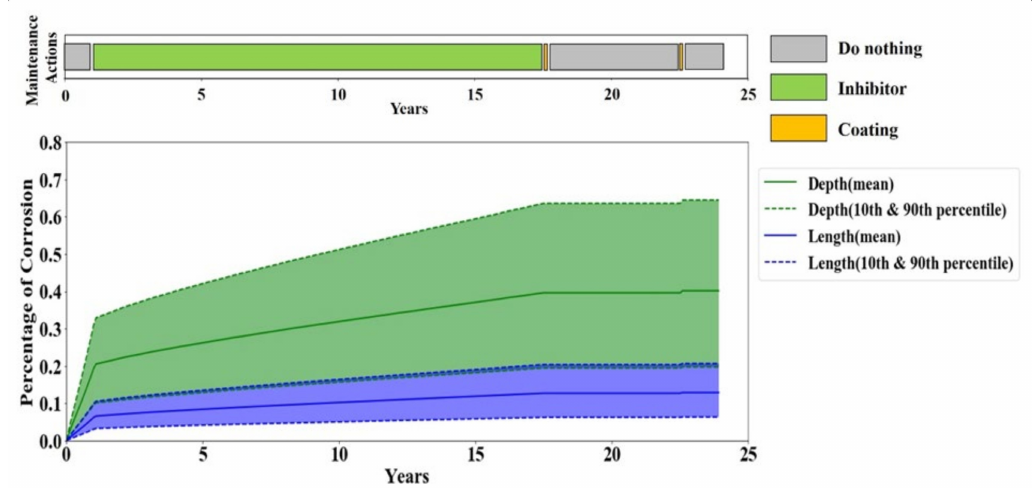
Figure 14. Corrosion depth and length in one full life evaluation episode for sensitivity scenario